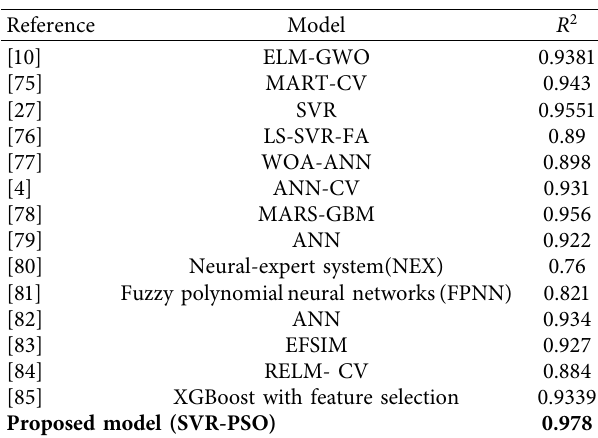
Table 6: Validating the SVR − PSO against predictive models collected from the